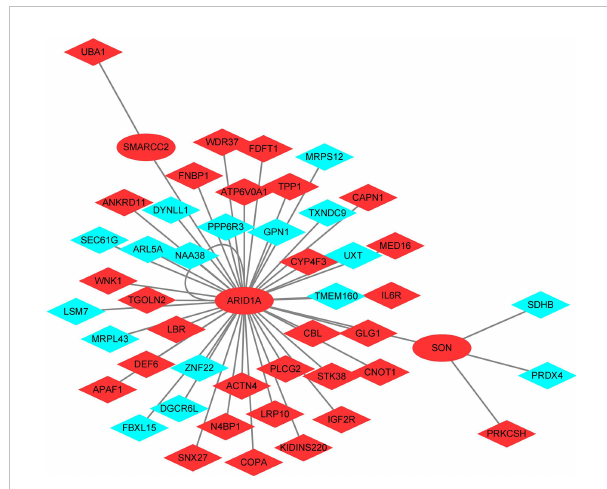
FIGURE 5 Transcription factors - shared differentially expressed genes regulatory network. Red: Up-regulated shared DEGS; Blue: Down- regulated shared